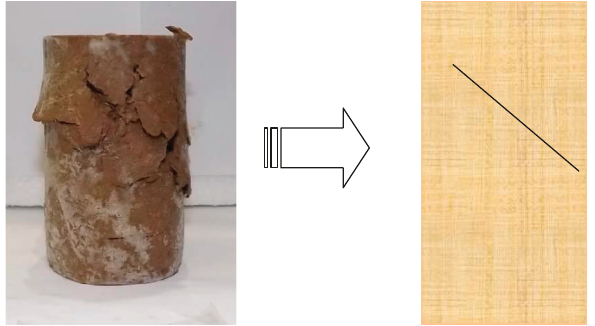
Figure 5: Failure mode of artificial frozen silty clay at − 10 ° C.